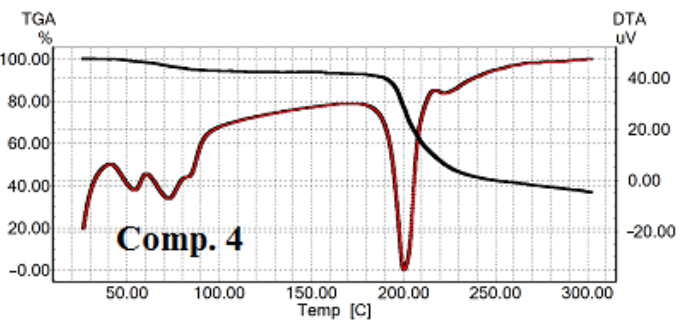
Figure 4. TGA/DTA curves for comp. 4 .